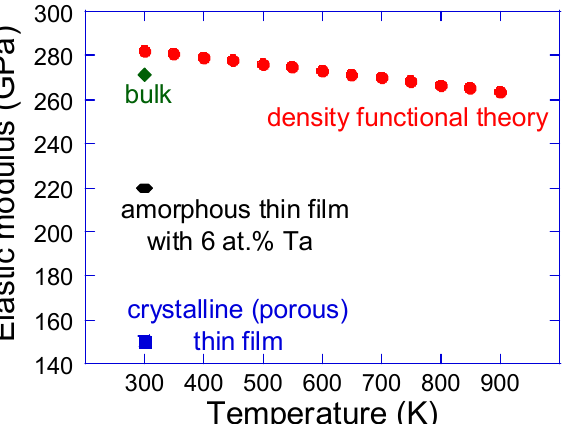
Figure 7. Elastic (Young’s) modulus as a function of temperature. Density functional theory data for ideal NbO 2 [92] are compared with the bulk value [95] as well as crystalline [99] and amorphous [85] thin films. It should be noted that the crystalline thin film is porous [99] and the amorphous sample contains Ta [85], making the comparison less straightforward.